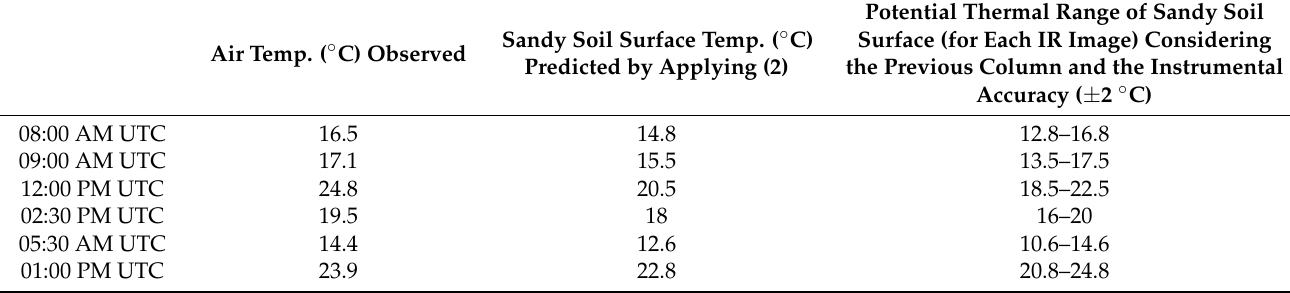
Table 2. Temperature data (30–31 October 2018).